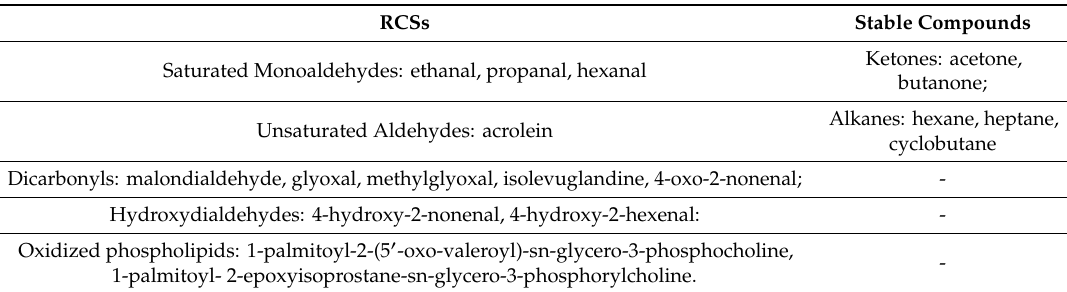
Table 1. Lipid hydroperoxides [1,3]. RCSs Stable Compounds Saturated Monoaldehydes: ethanal, propanal, hexanal Unsaturated Aldehydes: acrolein